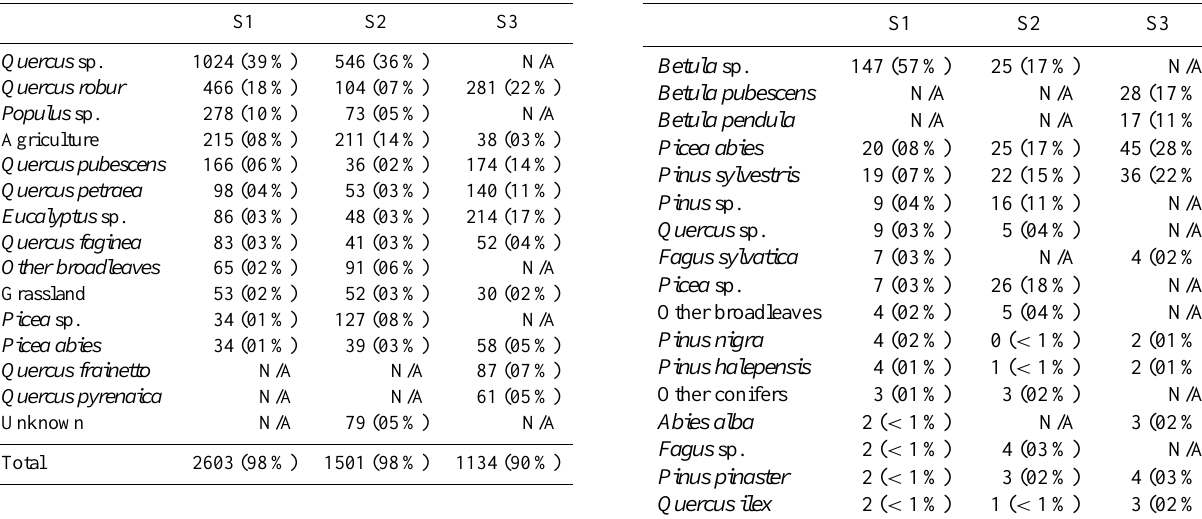
Table 3. Top emitters of monoterpenes (based on annual data, orig- inal countries), selected so that at least the ten most important emit- ters for each inventory is shown. Values in Gg yr − 1 .